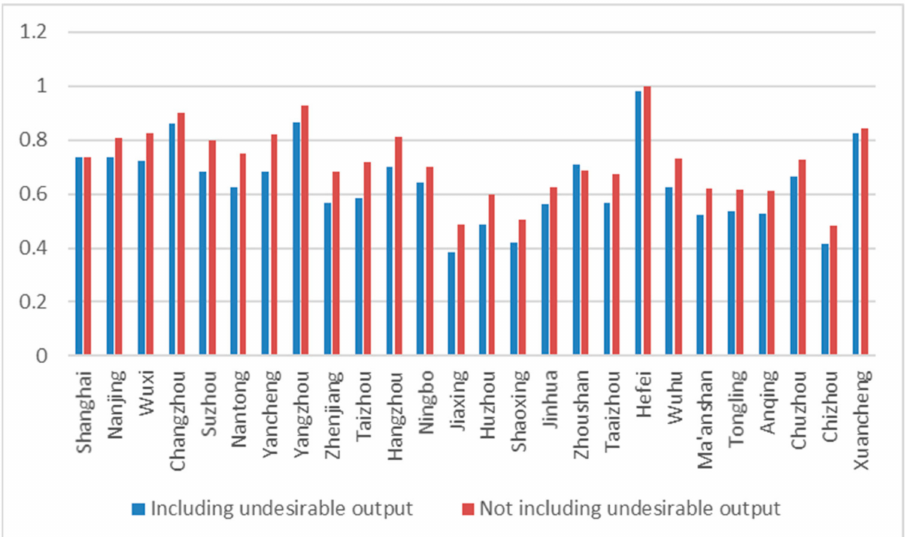
Figure 3. Urban Land Use Efficiency of Each City.